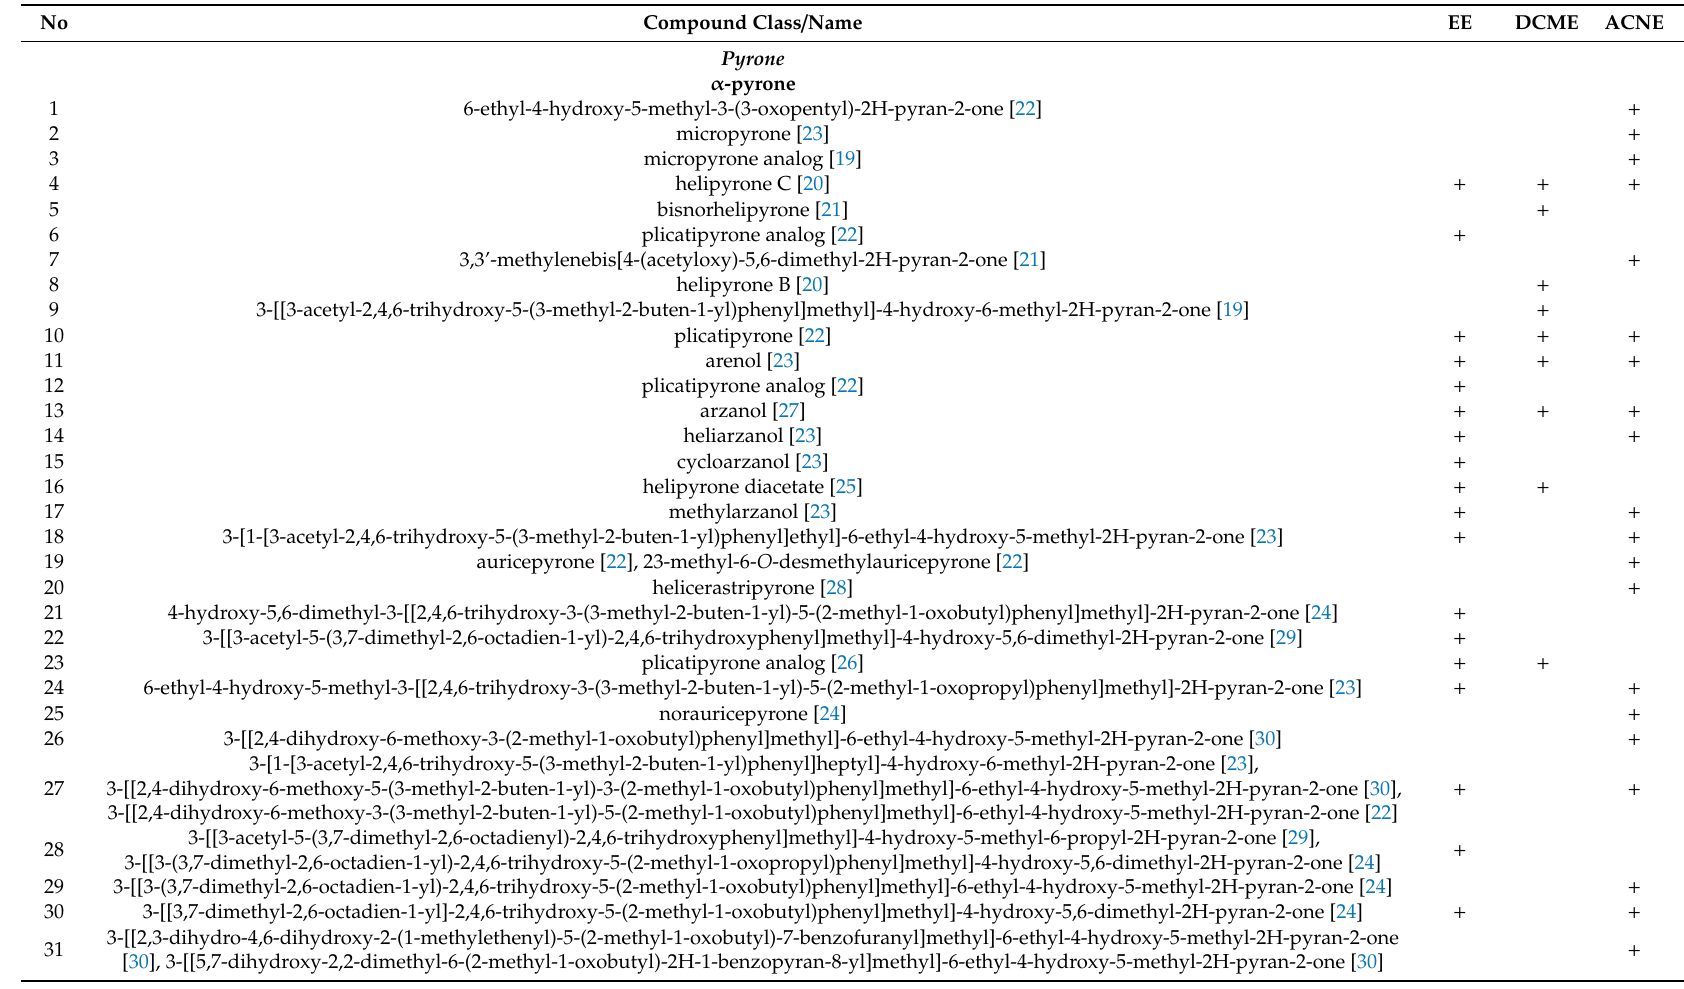
Table 1. Composition of H. plicatum ethanol (EE), dichloromethane (DCME), and acetonitrile oil (ACNE) extract analysed by HPLC-DAD /